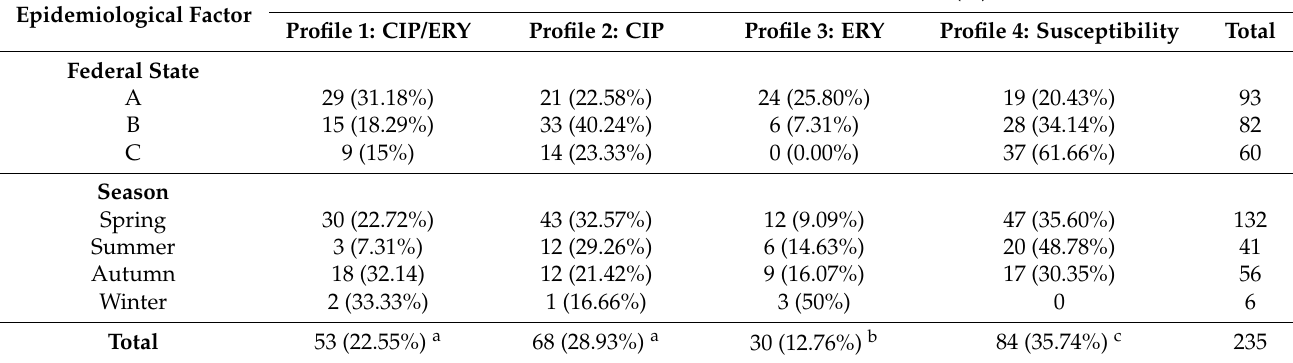
Table 2. Antimicrobial susceptibility profile of C. jejuni isolated from chicken carcass broken down by state and